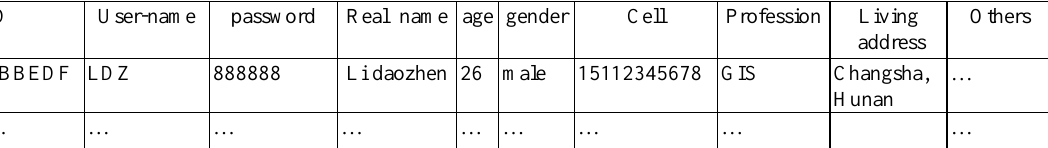
Table 1. The volunteer registration database